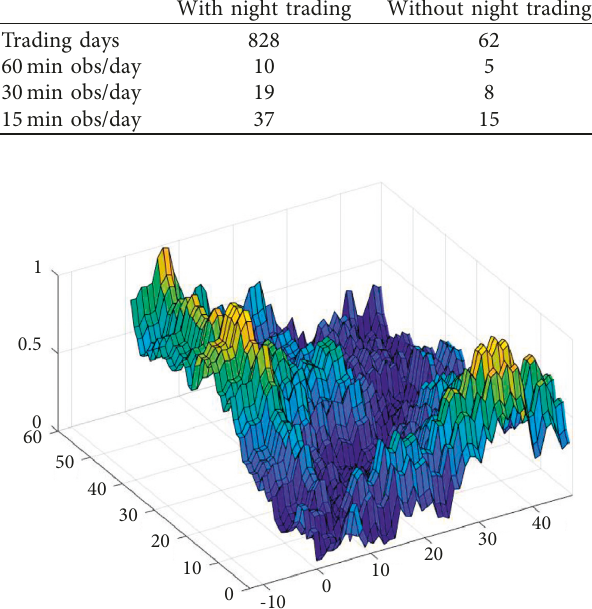
Figure 1: Distance matrix of simulation data.